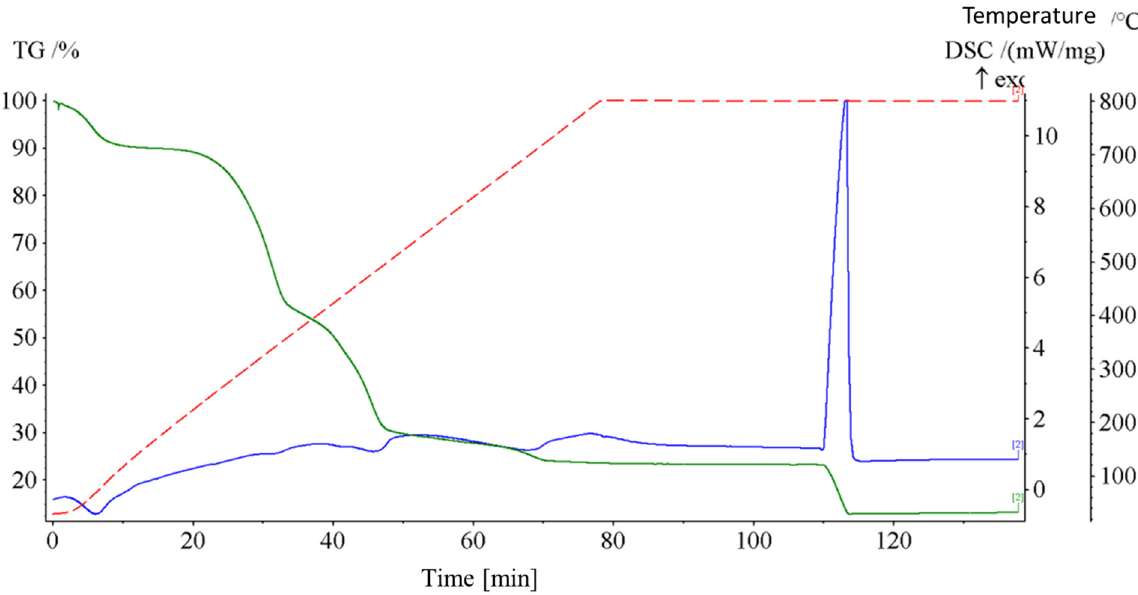
Figure 3. Thermogravimetric record of RDF.